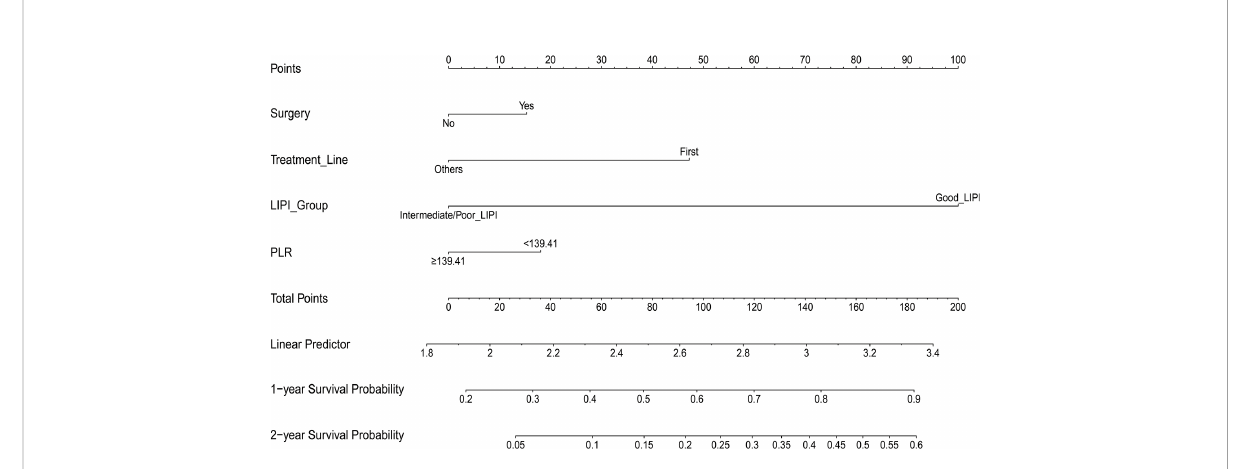
FIGURE 3 Nomogram for predicting 1- and 2-year survival in patients with metastatic gastric cancer.